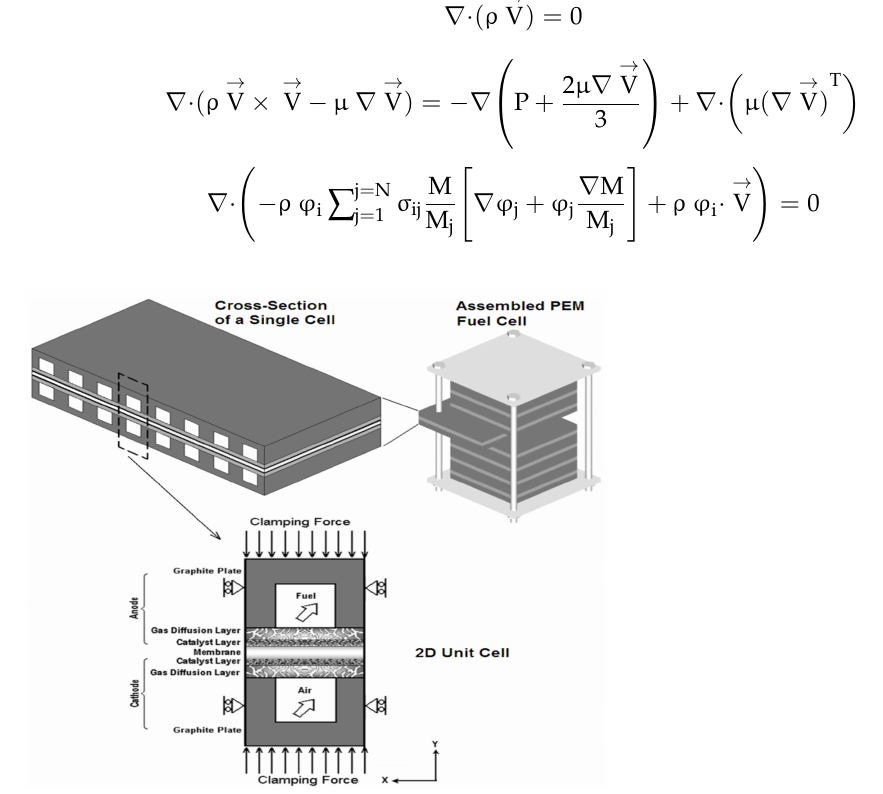
Figure 1. Schematic of the computational domain and boundary conditions. Table 1. Dimensions and characteristics of the FC